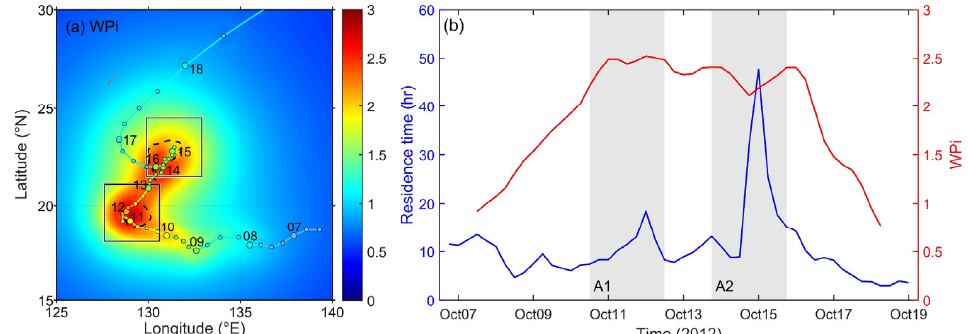
Figure 15. ( a ) Spatial distribution of the wind power index (WPi) caused by the passage of Typhoon Prapiroon. Two solid boxes are two focused domains of the sudden-turning stages of the typhoon, denoted A1 and A2. The coloured lines and dots represent the track and intensity of the typhoon. The black dotted lines indicate the − 6 °C isotherm of maximum SST cooling in Figure 5a. ( b ) Temporal evolution of residence time (blue solid line) and WPi (red solid line) averaged within 100 km of the typhoon centre. The grey shaded areas indicate the A1-ST and A2-ST stages.